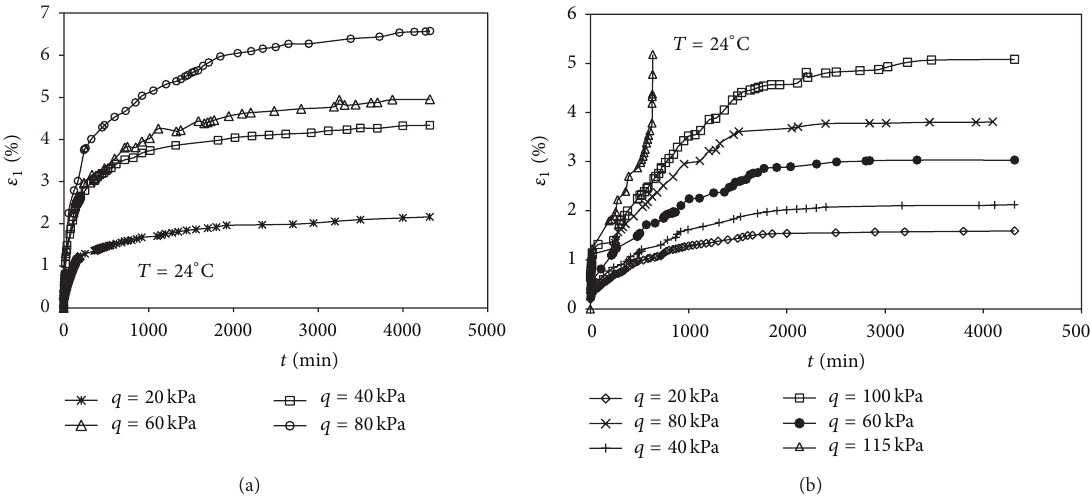
Figure 7: (a) Creep curve of drained creep test ( 𝑝 = 200 kPa). (b) Creep curve of undrained creep test ( 𝑝 = 200